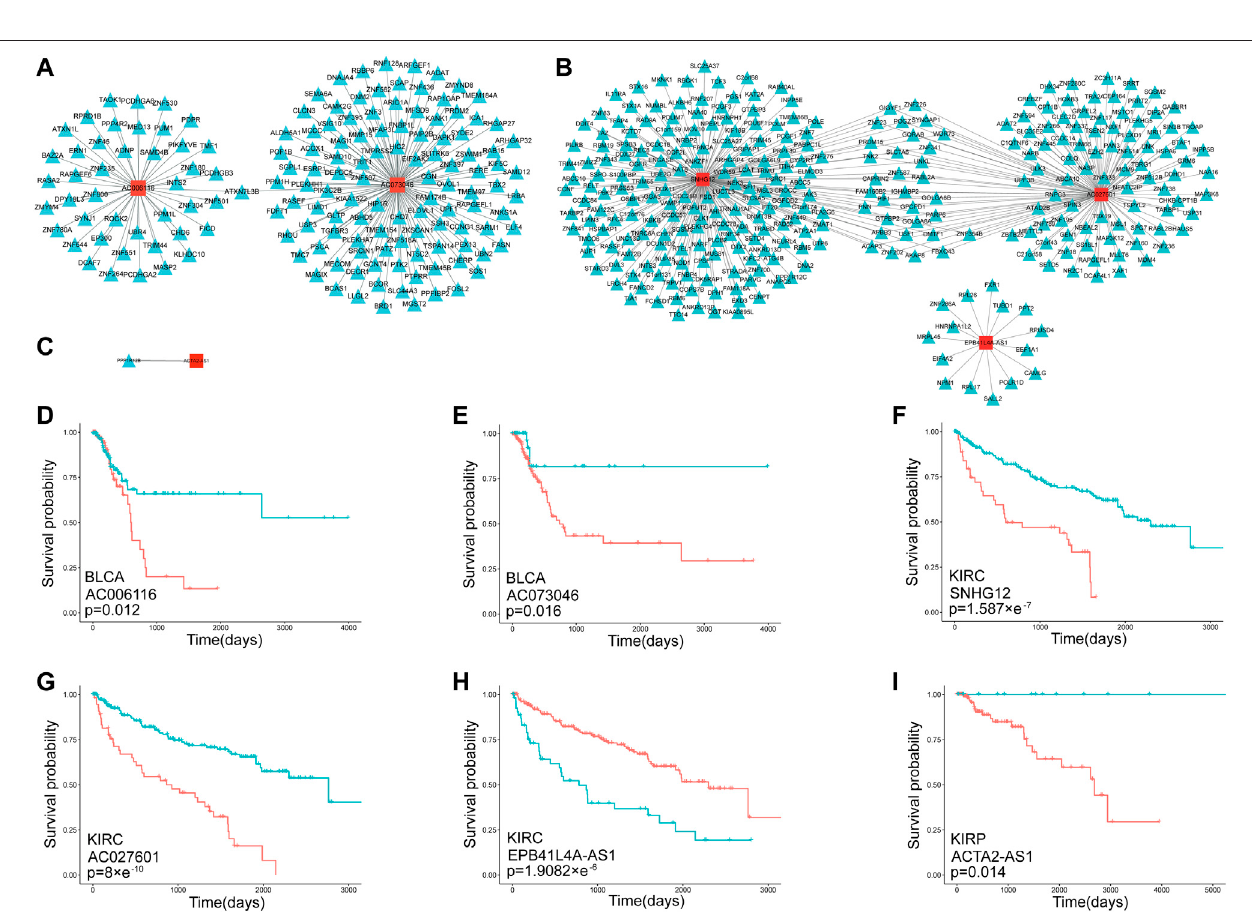
FIGURE 6 | The negatively correlated lncRNAs which speci fi c to each cancer in the ceRNA network (A) The ceRNAs of BLCA-speci fi c negatively correlated lncRNAs (B) TheceRNAs ofKIRC-speci fi cnegativelycorrelatedlncRNAs (C) TheceRNAs ofKIRP-speci fi cnegatively correlatedlncRNAs (D – I) Kaplan-Meier curves for thelncRNAsassociatedwitheachcancertypes.Thered linerepresentsthegroupwithahighlevelofexpression,whilethebluelinerepresentsthegroupwithalowlevel ofexpression.Additionally,the “ + ” onthelinesrepresentspatientswhowerelosttofollow-up.Atthispoint,thenumberofpatientsdecreasesbuttheoverallsurvival rate remains